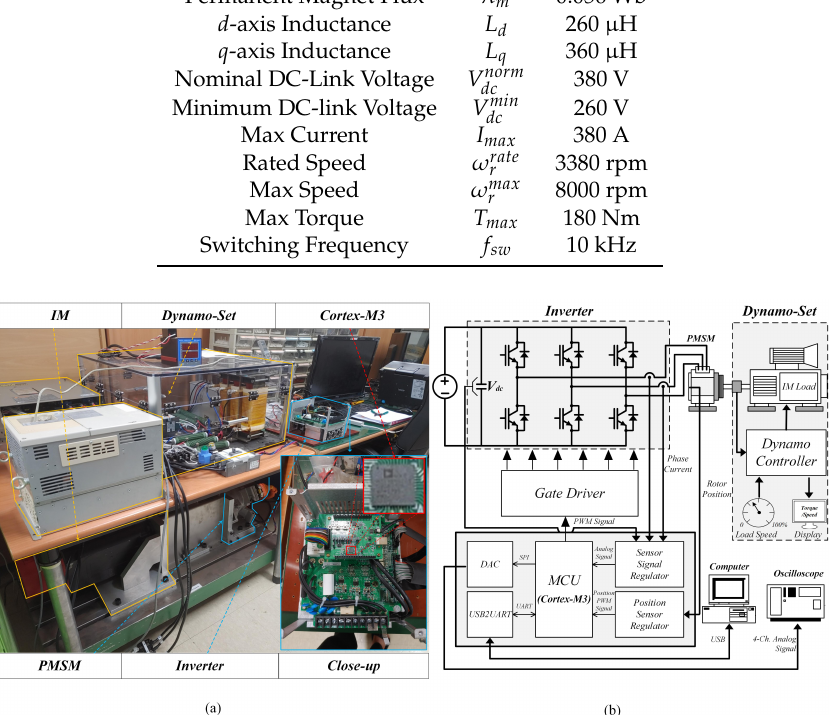
Figure 5. Experimental setup ( a ) Picture of experimental setup ( b ) Composition of the experimental